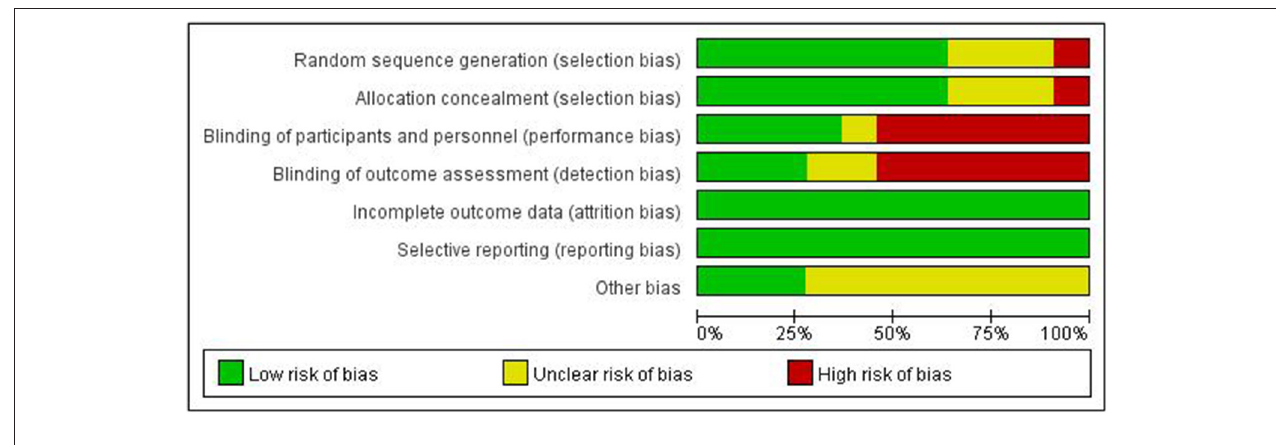
FIGURE 3 | Summary of risk of bias.